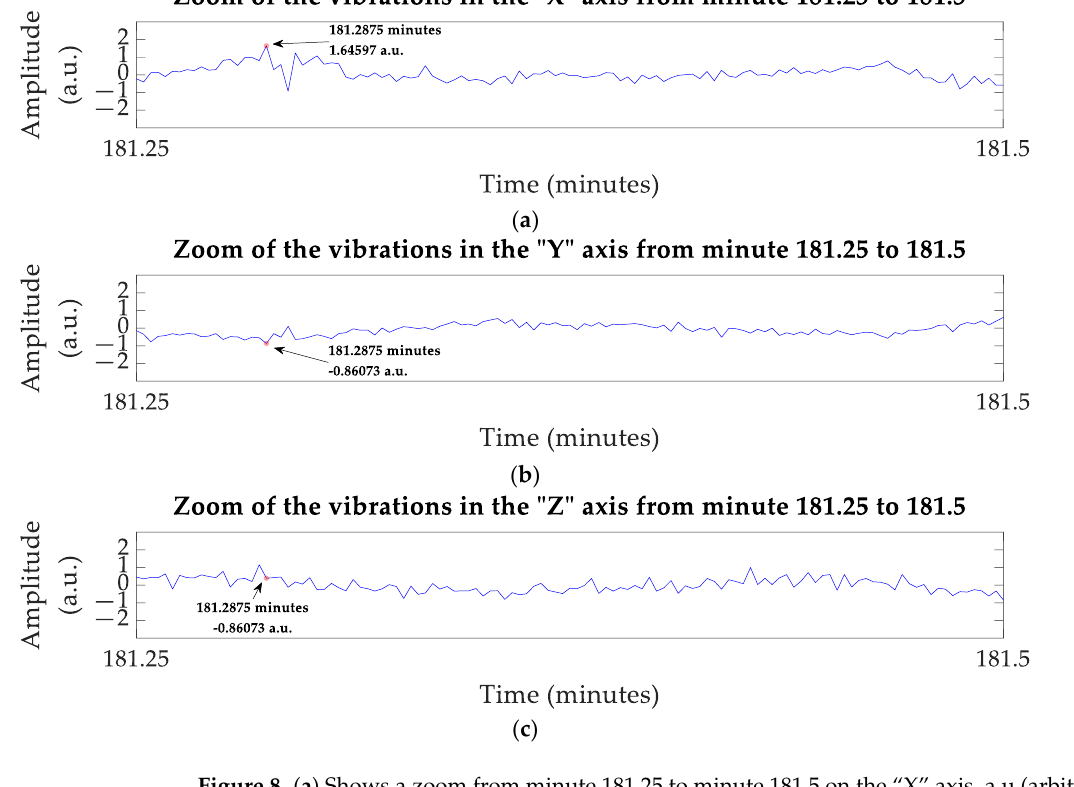
Figure 8. ( a ) Shows a zoom from minute 181.25 to minute 181.5 on the “ X ” axis, a.u (arbitrary units); ( b ) Shows a zoom from minute 181.25 to minute 181.5 on the “ Y ” axis, a.u (arbitrary units); ( c ) Shows a zoom from minute 181.25 to minute 181.5 on the “ Z ” axis, a.u (arbitrary units).